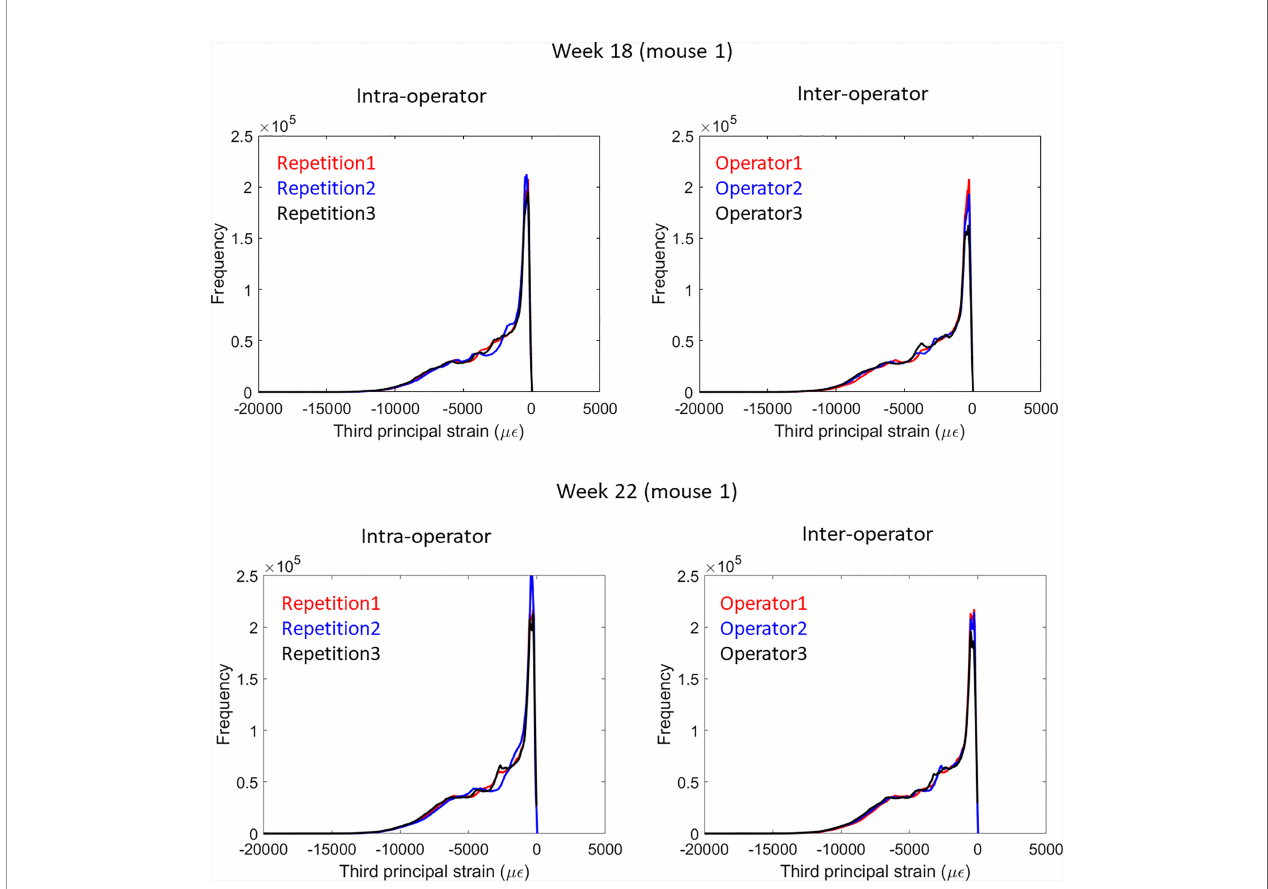
FIGURE 3 | Frequency plots for the distribution of the third principal strain obtained from intra-operator and inter-operator microFE analyses of one mouse tibia at week 18 (top) or 22 (bottom) of